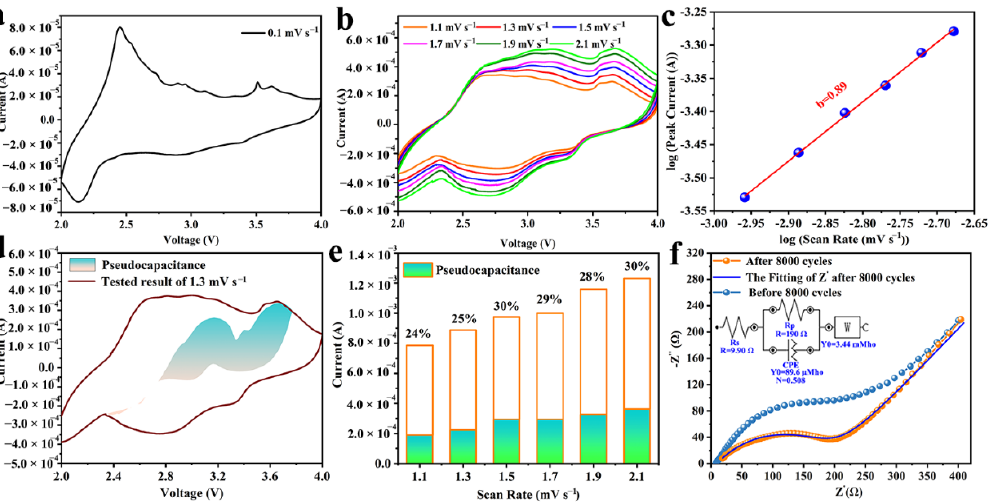
Figure 5. ( a ) The first cyclic voltammetry of NMO HTs vs. Na/Na + at 0.1 mV s −1 ; ( b ) Cyclic voltammetry curves of NMO HTs vs. Na/Na + at different scan rate between 1.1 mV s −1 and 2.1 mV s −1 at intervals of 0.2 mV s −1 ; ( c ) The b-value determination of the peak currents of cathode shows that charge storage of SCDC vs. sodium-tin alloy; ( d ) Cyclic voltammetry curves of NMO HTs vs. Na/Na + at 1.3 mV s −1 and the shadowed areas represent the capacitive contribution; ( e ) Separation of diffusion-controlled and capacitive charge at different sweep rates; ( f ) Nyquist dots of the NMO HTs vs. sodium-tin alloy in situ electrochemically derived by Sn foil (13 mm) inlaid with Na ring (1 mm) before and after 8400 cycles at 1 A g −1 (inset, the corresponding equivalent circuit diagram after 8400 cycles).